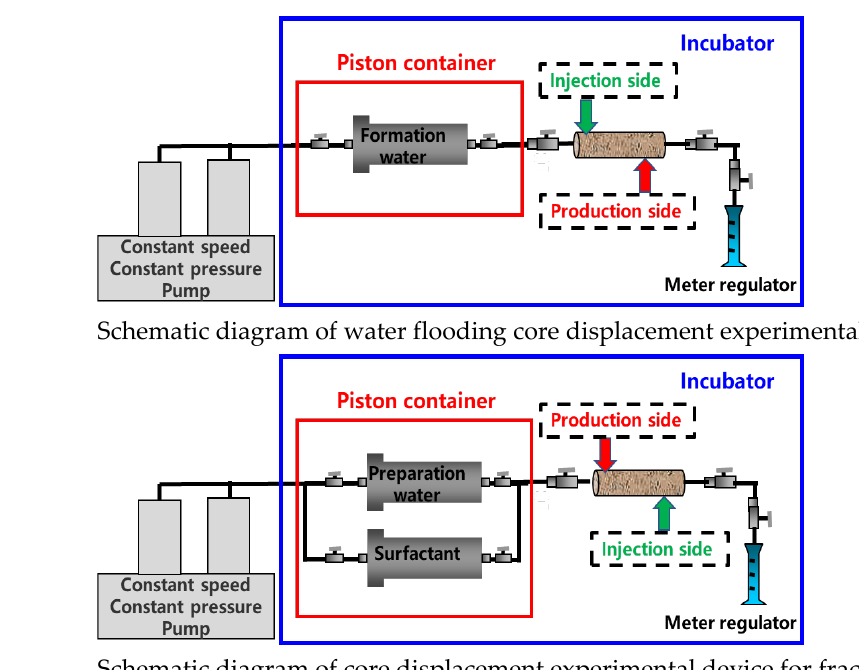
Figure 4. Design diagram of core displacement experiment scheme for fracture flooding.